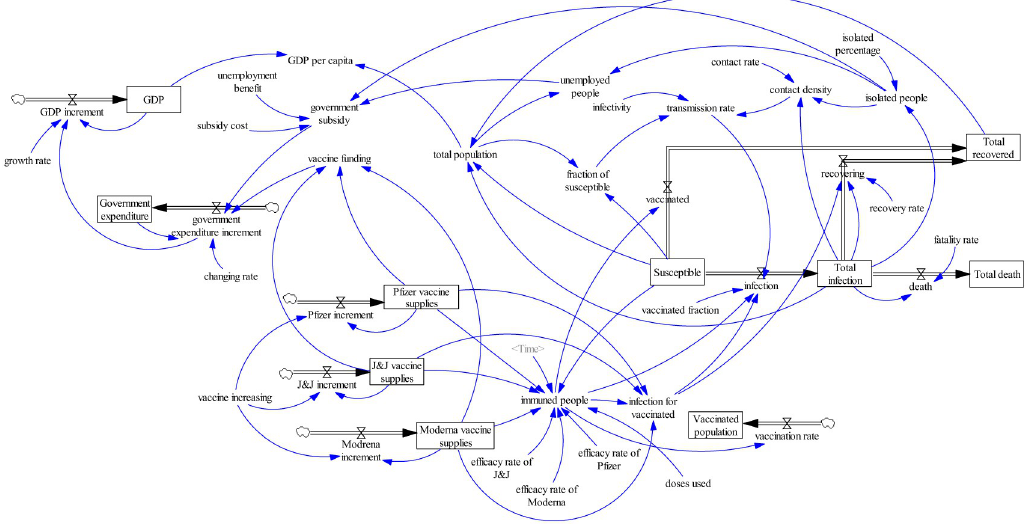
Fig 1. Proposed system dynamics framework of Covid-19 in the